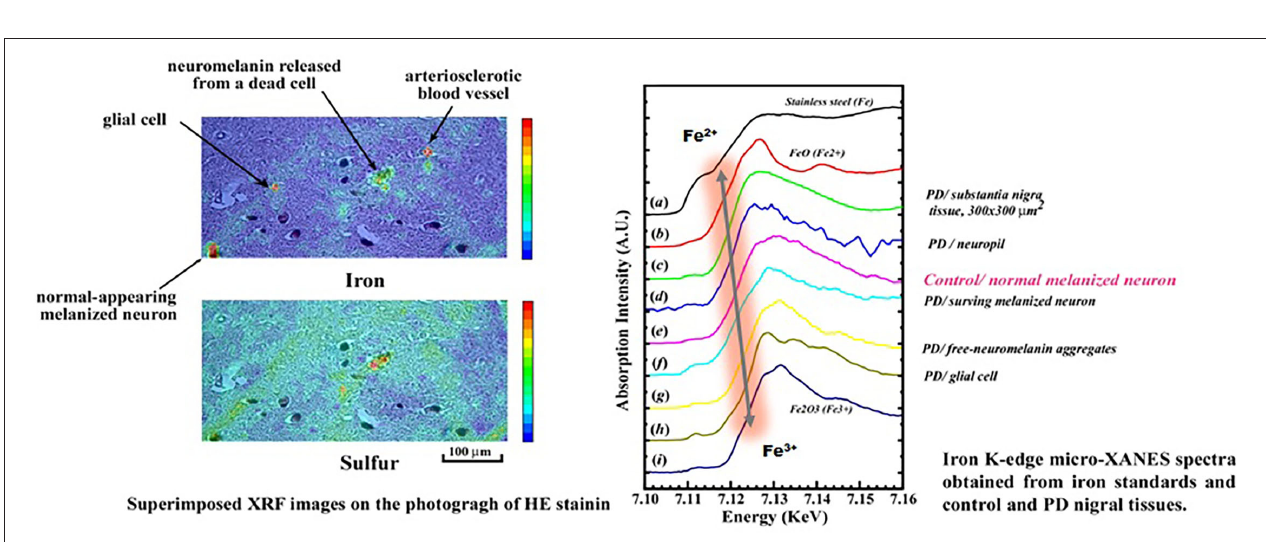
FIGURE 7 | XANES spectra of Fe obtained from of lumbar spinal cords of Control, sALS and fALS cases with SOD1 mutation (indicated by arrow).